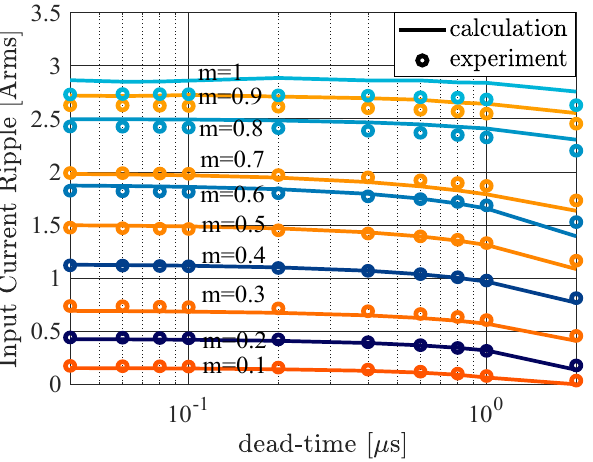
Figure 18. Calculation and experimental results of dead-time vs. rms input current ripple of the three-phase VSI (case 2